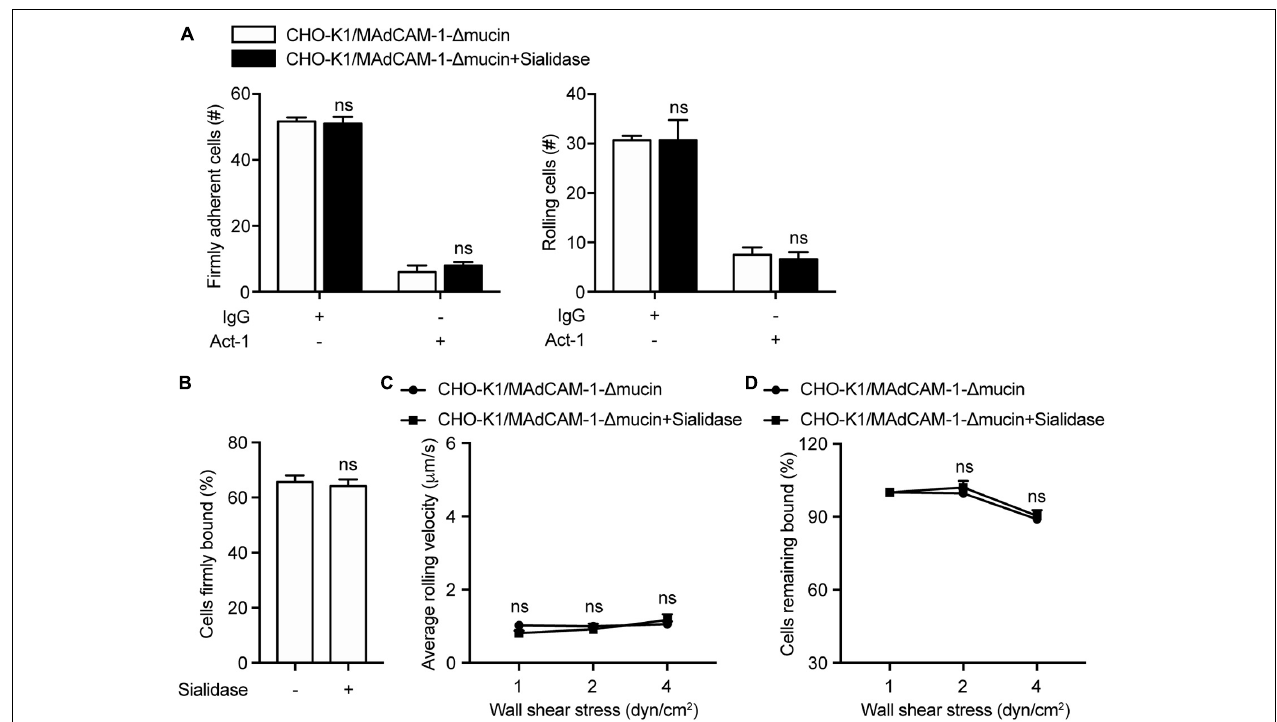
FIGURE 4 | Deletion of mucin-like domain of MAdCAM-1 abolishes the influence of sialidase on integrin α 4 β 7-mediated cell adhesion to CHO-K1 cells. Adhesive behaviors of 293T- α 4 β 7 cells on CHO-K1/MAdCAM-1- (cid:49) mucin cells. (A) The number of rolling and firmly adherent 293T- α 4 β 7 cells was measured at a wall shear stress of 1 dyn/cm 2 . Cells were pre-treated with murine IgG (10 µ g/ml) or α 4 β 7 blocking antibody Act-1 (10 µ g/ml) for 10 min at 37 ◦ C. (B) Percentage of cells firmly bound to CHO-K1/MAdCAM-1- (cid:49) mucin cells at a wall shear stress of 1 dyn/cm 2 . (C) Average rolling velocity of 293T- α 4 β 7 cells that adhered to CHO-K1/MAdCAM-1- (cid:49) mucin cells at indicated wall shear stresses. (D) Resistance of 293T- α 4 β 7 cells to detachment at increasing wall shear stresses. One representative result of three independent experiments is shown. Data represent the mean ± SEM ( n ≥ 3). ns: not significant (Student’s t